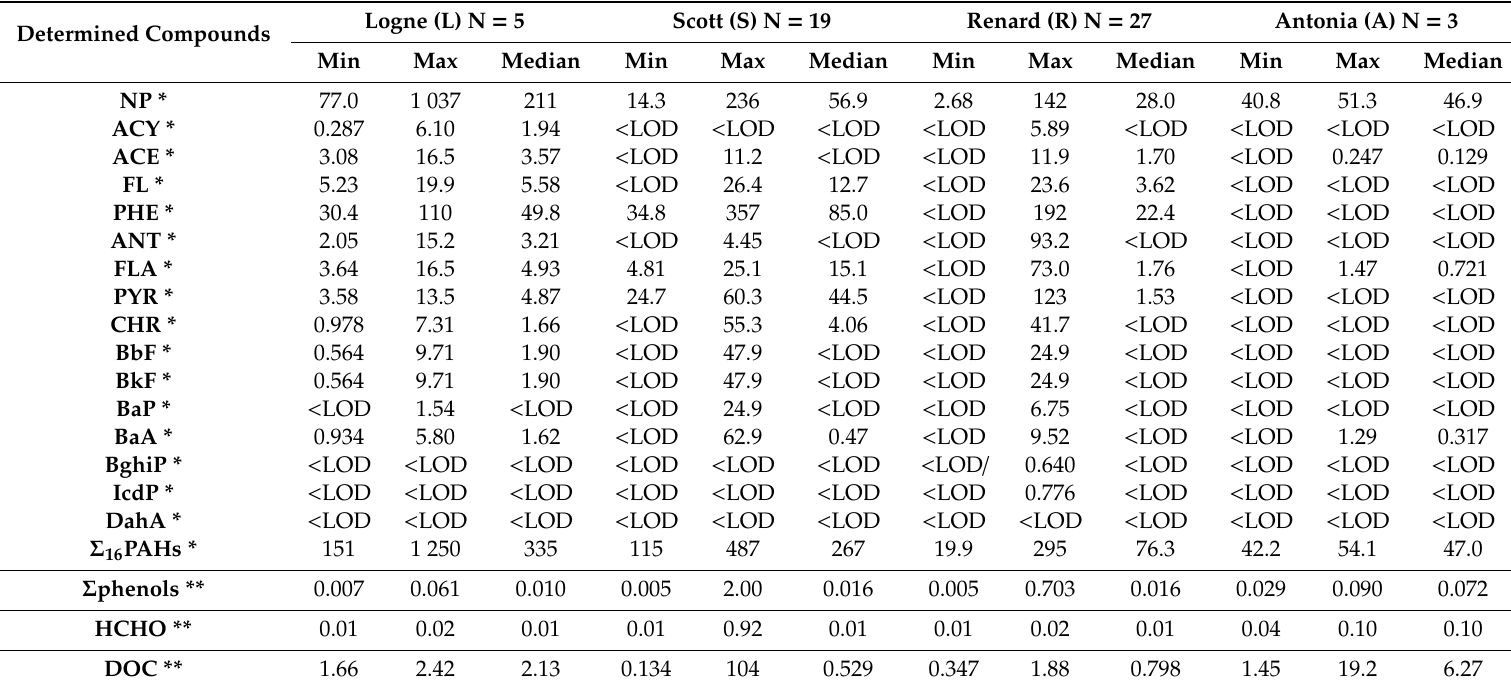
Table 2. Environmental datasets for all collected